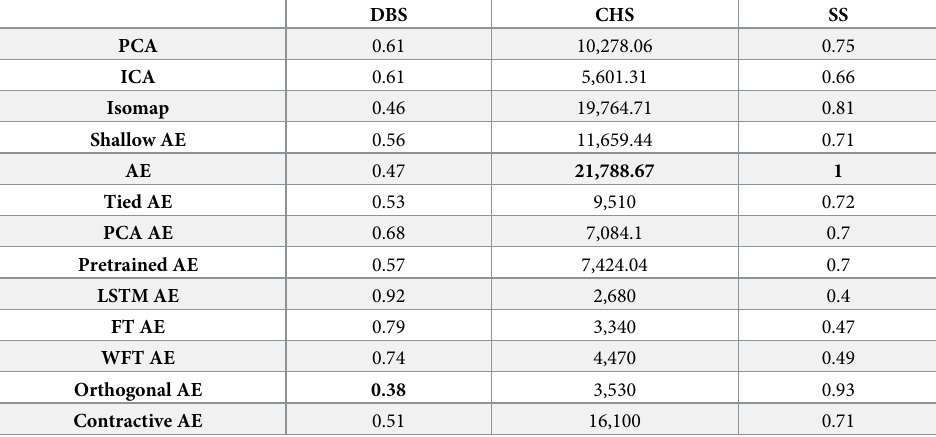
Table 10. Comparison of different autoencoder variations vs state-of-the-art methods on real data channel 4, the optimal value of neighbours for Isomap was found as 30 through grid search. DBS CHS